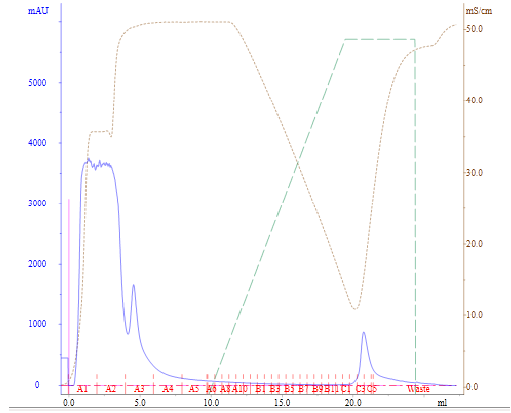
Figure 1. Purification of rhIFNα2b. A1-A10= flow through fractions; B1-B11= washing fractions and C1 to C5= elution fractions